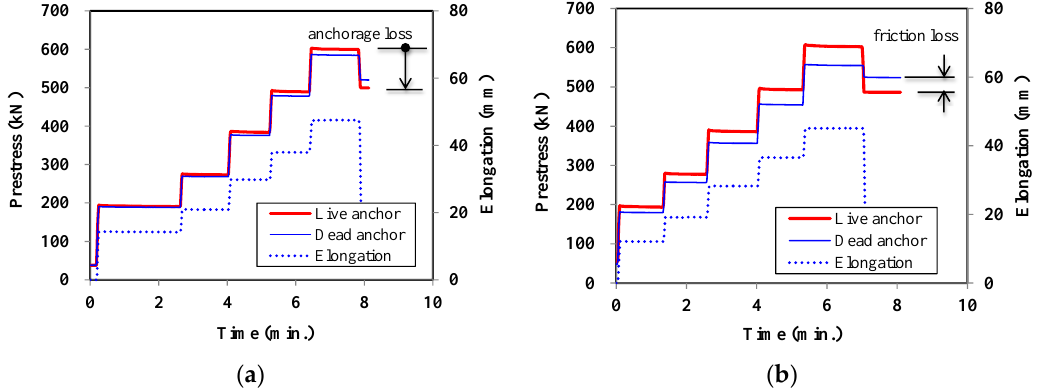
Figure 10. Pre-stress and elongation measured at the anchorage. ( a ) P25 specimen; ( b ) P50 specimen. The pre-stress measured at the live end coincided well with the applied pressure measured at the hydraulic jack. The measured load at the dead end was smaller than that at the live end due to friction losses that occurred in the tendon. The gap between loads at the live and dead anchors varies with respect to the test specimens. As the curvature of the tendon profile increased, the difference